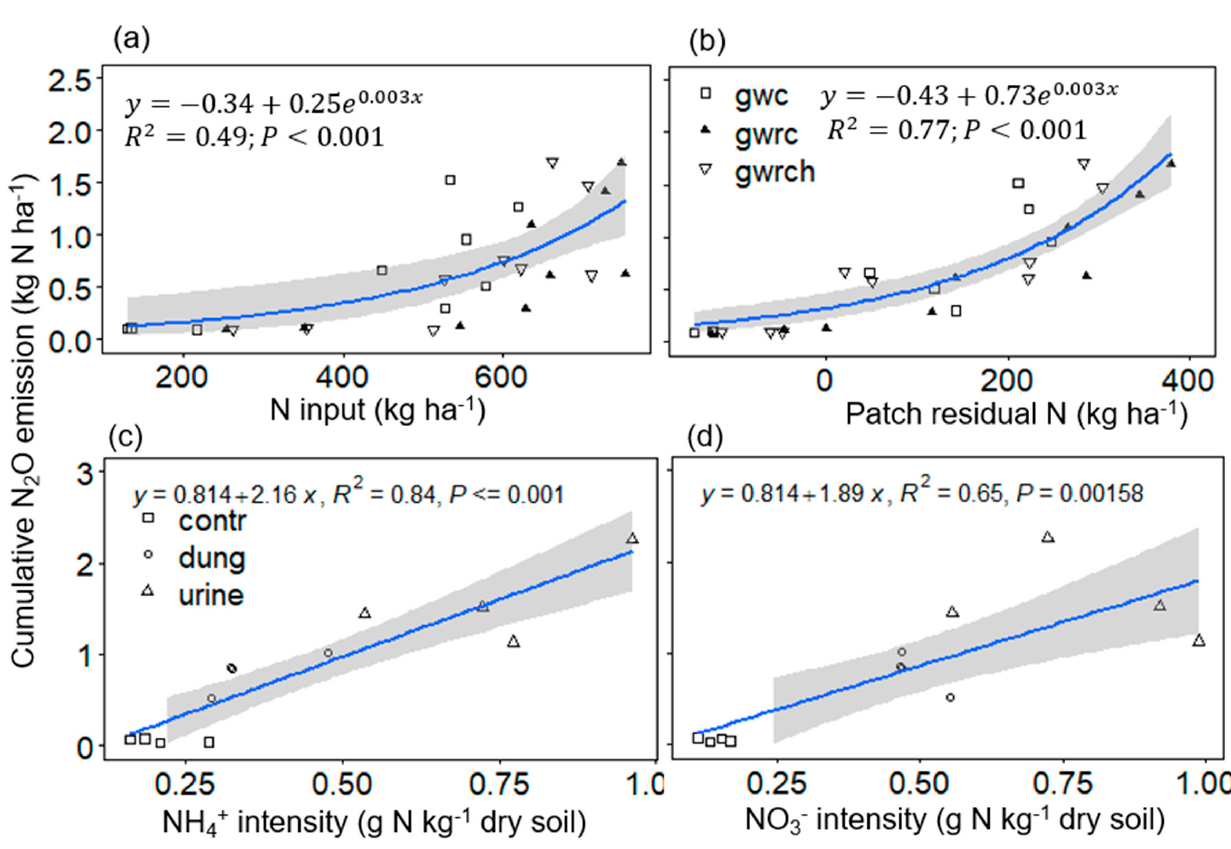
Figure 5. Best models showing stoichiometric relationships between the cumulative N 2 O-N emission and ( a ) N input, ( b ) patch residual N, ( c ) ammonium intensity of ( d ) nitrate intensity. ( a , b ) Based on data from experiment 2, ( c , d ) based on data from the irrigated experiment (3); the grey region is 95% confidence interval.